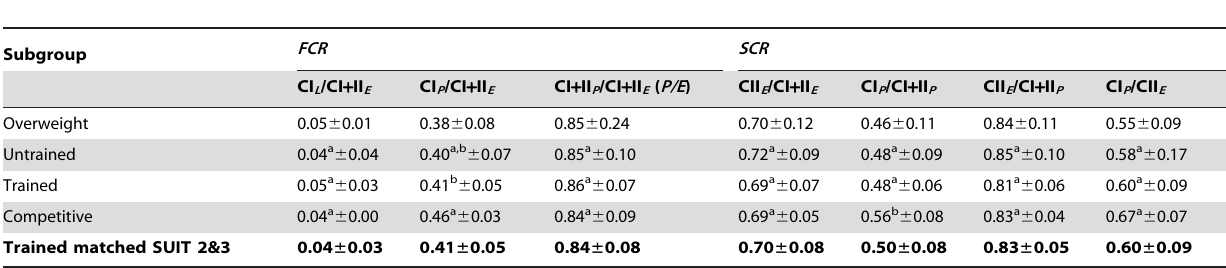
Table 3. Respiratory parameters from substrate-uncoupler-inhibitor titration protocol 1 (SUIT1) applied on equine permeabilized fibres of triceps brachii : flux control ratio ( FCR , with normalization for CI + II E ) and substrate control ratio ( SCR , assuming CII E = CII P ); ( N